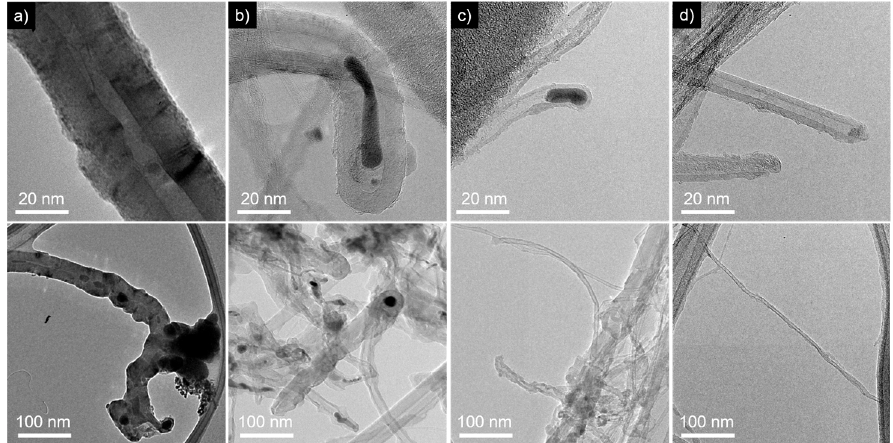
Figure 7. TEM images of DLICVD experiments at high magnification (top) and low magnification (bottom) conducted using an aspiration temperature of 225 °C, a 1 mL/h injection rate, a 1.25 wt.% catalyst concentration, using EtOH as a carbon source, and a reaction temperature of ( a ) 700 °C, ( b ) 800 °C, ( c ) 900 °C, and ( d ) 1000 °C.